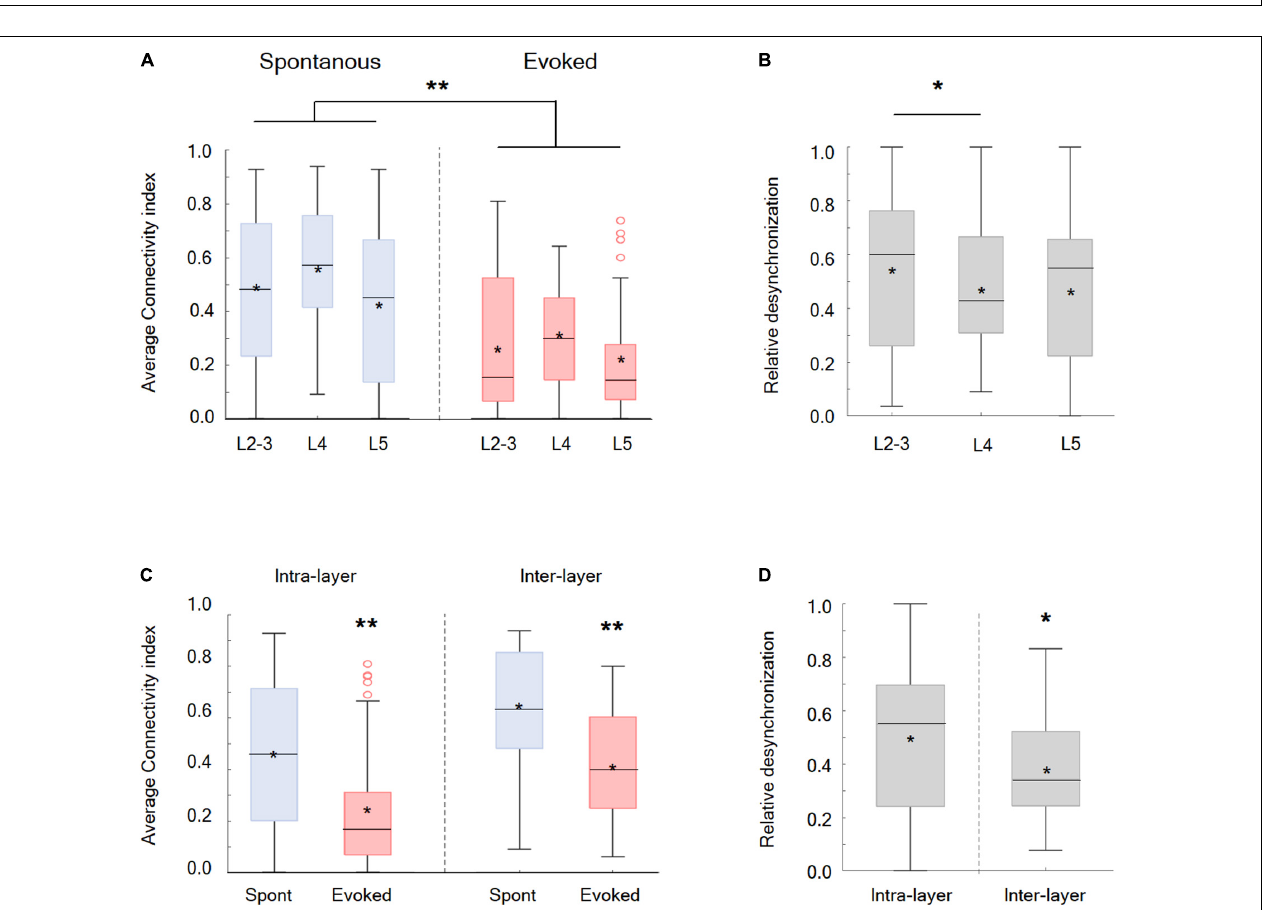
FIGURE 3 | Desynchronization in the different cortical layers in the wS1 cortex and within different zones inside the layers. (A) Box plots of the connectivity index in spontaneous (blue) versus evoked (red) whisker activation in putative layers 2-3, 4, and 5 of the wS1 barrel cortex (209 neurons from 7 rats). The middle line in the box plots represents the median value and the asterixis represents the mean value. A value of ** p < 0.01 is for the comparison of the data for each layer between spontaneous and evoked conditions. The comparison was obtained with the t -test or the Mann-Whitney non-parametric test when the data did not adhere to a normal distribution (L2-3 and L5 of the evoked conditions). Comparison between the layer under both the spontaneous and evoked states yielded no significant differences, using either the ANOVA or the Kruskal Wallis non-parametric test. (B) Box plots of the relative desynchronization [(Evoked-spont)/spont)] are presented for each putative cortical layer. The middle line in the box plots represents the median value and the asterixis represents the mean value. A value of * p < 0.05 was obtained with the Mann–Whitney non-parametric test. (C) Box plots of the connectivity index in spontaneous (blue) versus evoked (red) activities for neuronal pairs located within the same layer (intra-layer) and in different layers (inter-layer). The middle line in the box plots represents the median value and the asterixis represents the mean value. A value of * p < 0.05 obtained with either the Mann-Whitney non-parametric test (intra-layer) or the t -test (inter-layer). (D) Box plots of the relative desynchronization [(Evoked-spont)/spont)] is shown for functionally connected neurons located within the same layer (intra-layer) and in different layers (inter-layer). The middle line in the boxplots represents the median value and the asterixis represents the mean value. A value of * p < 0.05 was obtained with the t -test.